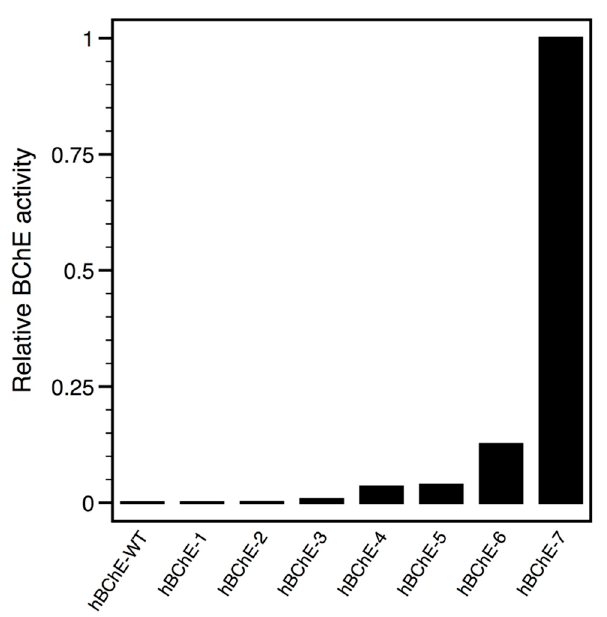
Figure 2. Comparison of BChE activity in the bacterial soluble extracts of the different BChE constructs. An aliquot on each soluble extract from pThioHis constructs of hBChE-wild-type (WT) and hBChE-1 to hBChE-7 was measured for butyrylthiocholine hydrolase activity. Activities were normalized to the highest measured sample.